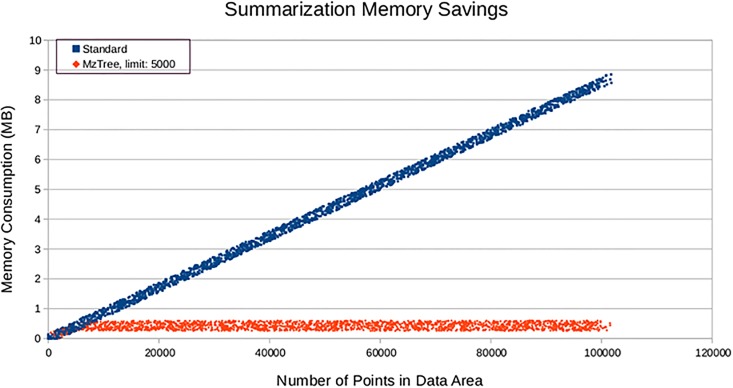
Summarization memory savings.Of all methods discussed in this paper, MzTree is the only one that can handle data sets that require more RAM than the application provides. MzTree’s summarization feature (shown here with limit set to 5,000 points) allows users to work with arbitrarily large data sets even in situations where available RAM is less than that required to hold the unsummarized set of returned points, such as system memory limits or visualization rendering limits.